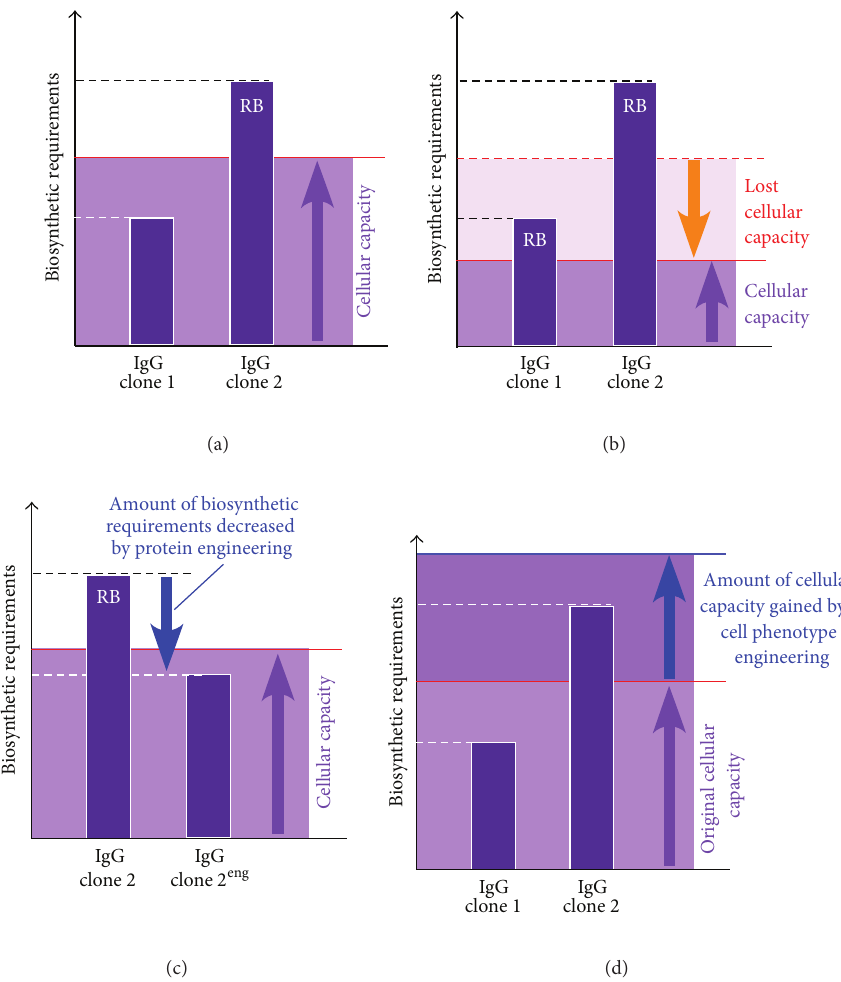
Figure 2: Schematic representation of the relationship between individual IgG clones’ biosynthetic requirements and intrinsic cellular capacity. (a) In this hypothetical setting, two IgG clones 1 and 2 have different levels of resource requirements during biosynthesis (shown in the vertical axis). The cells have sufficient capacity to support clone 1’s biosynthesis, but do not have the capacity to meet the requirement of clone 2. Clone 2 ends up aggregating into Russell body (RB). (b) The same pair of clones were expressed in the same cell background. In this hypothetical setting, however, the cells have lost a part of their capacity due to stress, senescence, pathological changes, and so forth. As a result, both IgG clones come to develop RB phenotypes. (c) An example of successful protein engineering that reduced the biosynthetic requirements of IgG clone 2. Engineered clone 2 eng no longer induces RB in the same cell host. (d) In this setting, cell phenotype engineering strategies increased the overall capacity of the cell host. The clone 2 no longer forms RB in the engineered cell